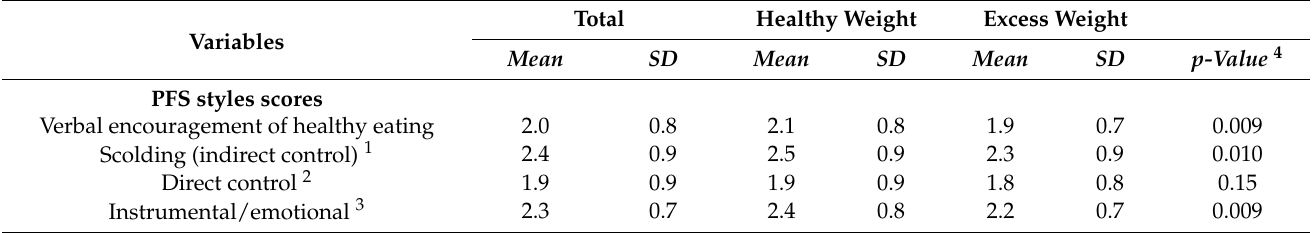
Table 2. Parental feeding styles, diet quality, and anthropometric indicators in Costa Rican adolescents stratified by excess weight categories ( n =